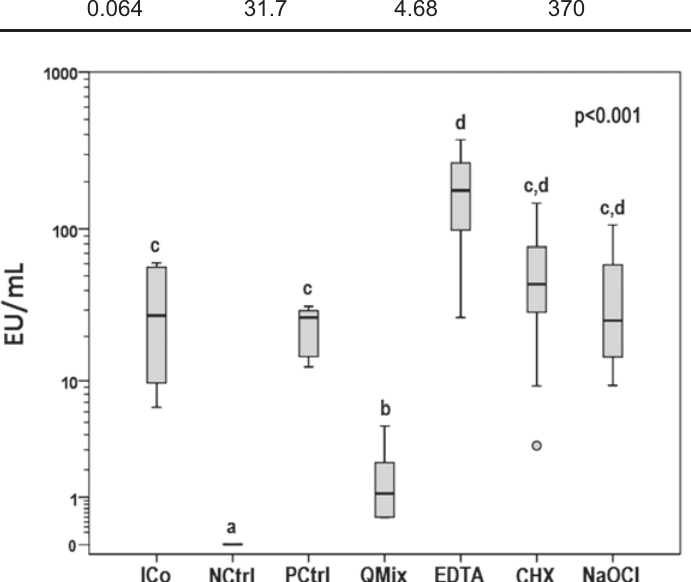
Figure 1- Endotoxin values. ICo: Initial count; PCtrl: Positive control; NCtrl: Negative control. Different index